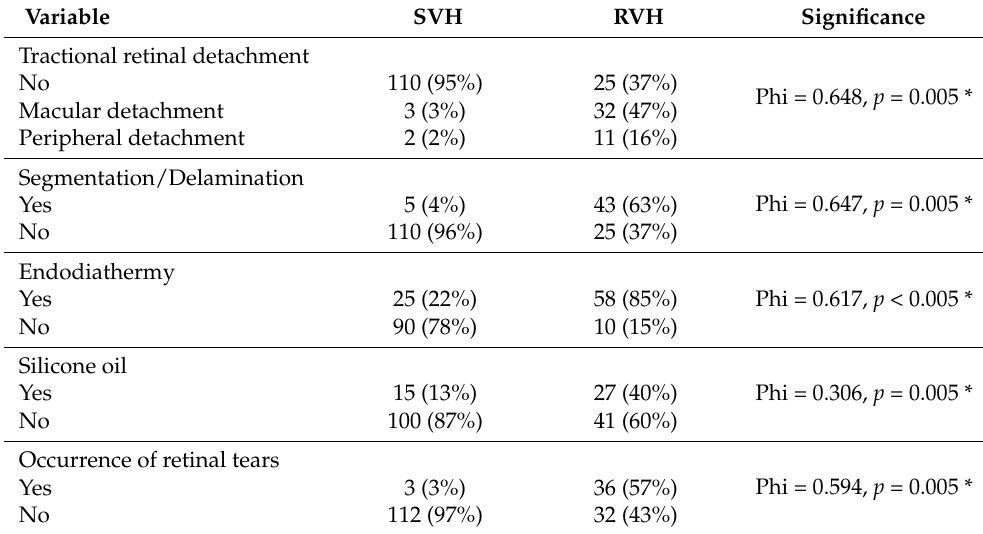
Table 3. Differences in surgical variables between the two groups of patients studied with proliferative diabetic retinopathy. Eyes in the recurrent vitreous hemorrhage (RVH) group were more likely to have a tractional retinal detachment in which segmentation and delamination were applied, silicone oil was used more frequently, and more retinal tears were observed during the vitrectomy. * Chi-squared test. Variable SVH RVH